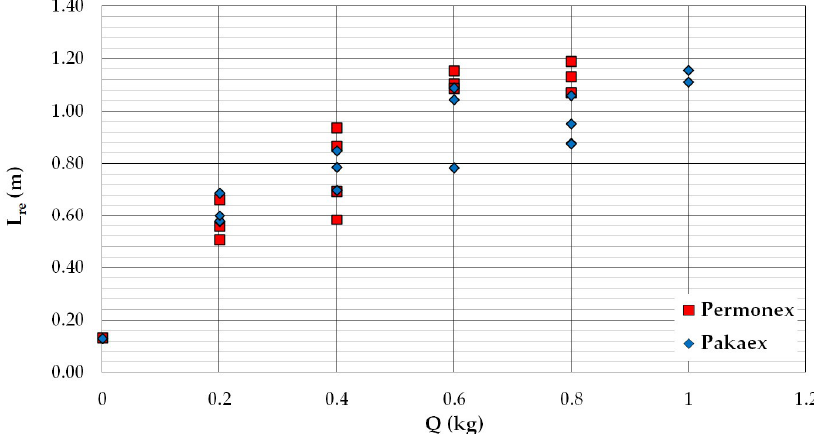
Figure 11. The dependence of diameter of enlargement D re (m) on the mass of explosive charge Q (kg), for Permonex V19 and Pakaex.